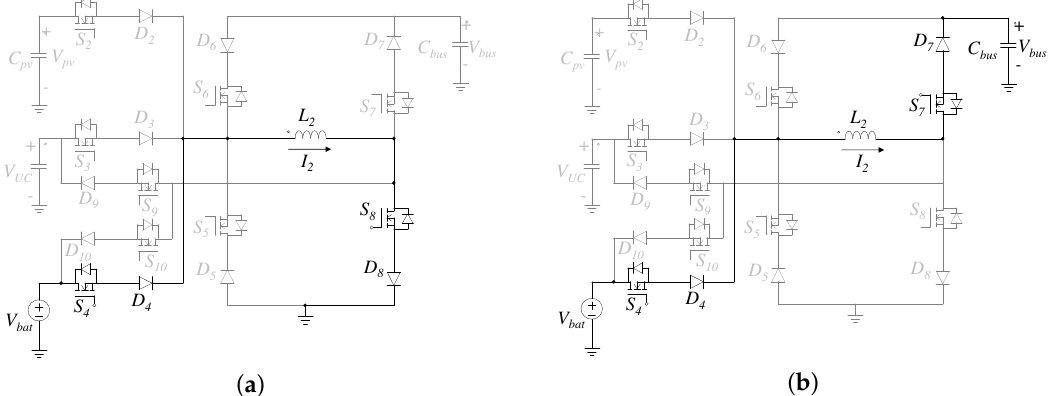
Figure 8. Operating modes of the multiple-input converter, ( a ) charge of the inductor, ( b ) discharge of the inductor. Table 3. Operating modes of the multiple-input